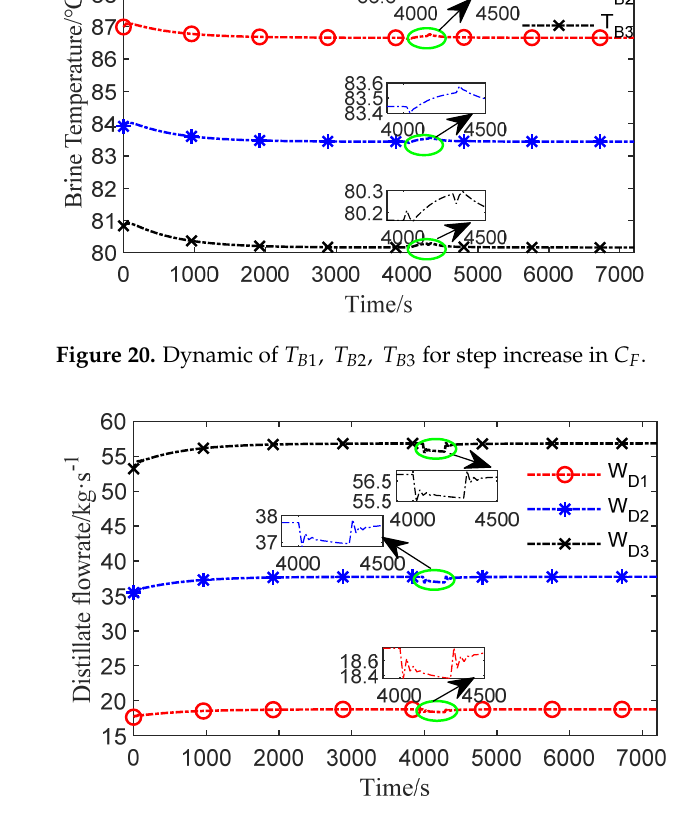
Figure 21. Dynamic of W D 1 , W D 2 , W D 3 for step increase in C F